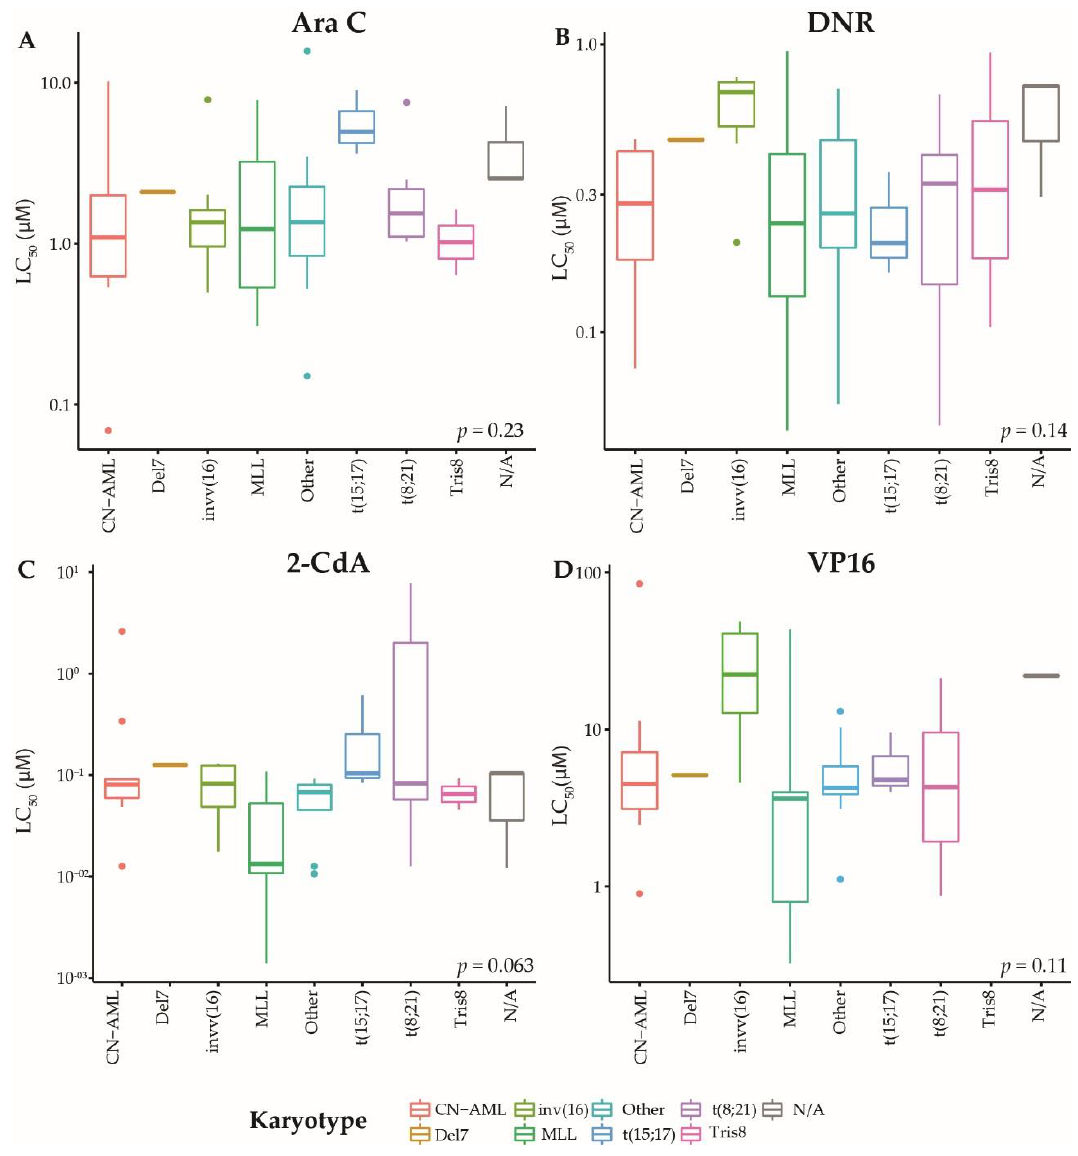
Figure A2. LC 50 (µM) per karyotype group of patient samples from the discovery cohort towards ( A ) Figure A2. LC 50 ( µ M) per karyotype group of patient samples from the discovery cohort towards Ara C, ( B ) DNR, ( C ) 2-CdA, ( D ) VP16. P-values were calculated using Kruskal-Wallis comparison for ( A ) Ara C, ( B ) DNR, ( C ) 2-CdA, ( D ) VP16. p -values were calculated using Kruskal-Wallis comparison multiple groups. for multiple